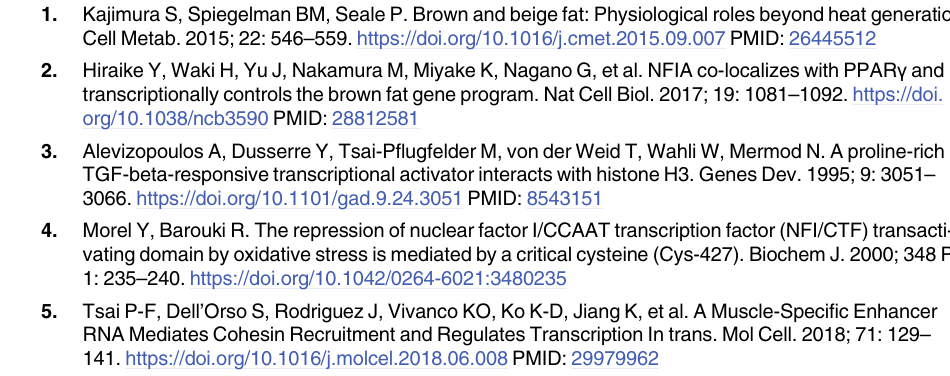
S1 Table. A list of Primers used for qPCR analysis. S2 Table. A list of guide RNA sequences used for CRISPR dCas9-Krab experiments. S3 Table. All numerical data underlying graphs shown in this